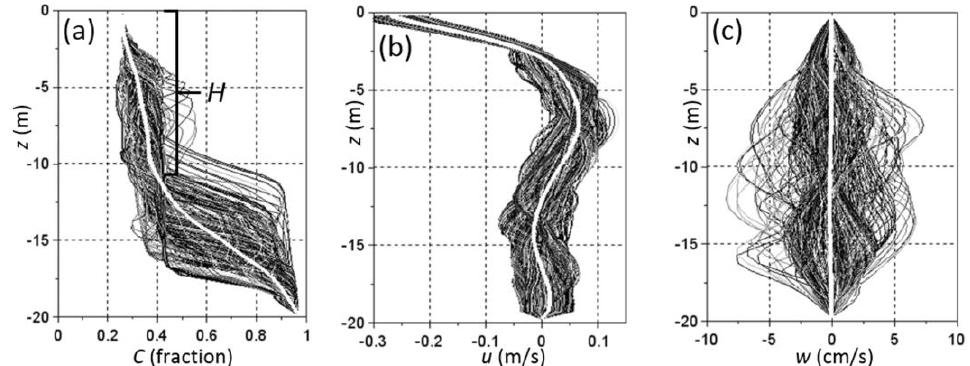
Figure 8. Same as Figure 4, but for Scenario B with τ x = −0.1 Pa and N 2 = 2 × 10 −4 s −2 . Shown is the evolution of the concentration field C after ( a ) 1.8 h, ( b ) 5 h and ( c ) 10 h of simulation. See GIF Animation S2 for a simulation of this experiment.